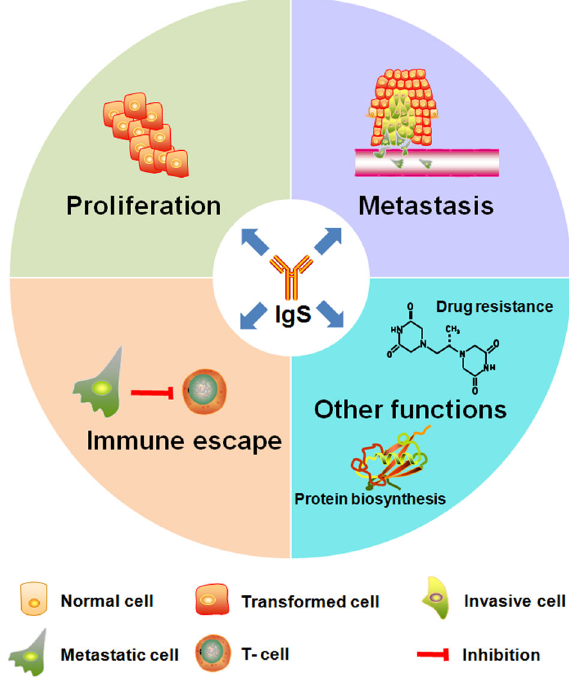
Fig. 3 Schematic illustration of biological functions of tumor- derived Igs. Tumor-derived Igs are involved in the following four aspects of tumor development and progression: (1) tumor cell growth and proliferation; (2) tumor cell migration, invasion, and metastasis; (3) tumor immune escape; (4) other biological functions. Other biological functions of tumor-derived Igs are as follows: (1) immunity regulation; (2) promotion of drug resistance; (3) involvement of cancer-associated diabetes; (4) in fl uence of tumor-associated throm- bosis; (5) mediation of CSC potential; (6) regulation of cell morphogenesis, cell cycle process, fatty acid biosynthetic process, protein biosynthesis, and antimicrobial (virus, bacterium, and